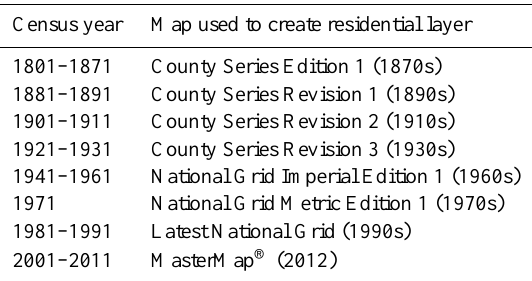
Table A2. Historic maps used to create residential masks for each census year. All maps sourced from Digimap ® Crown Copyright and Landmark Information Group Limited (2014). All rights